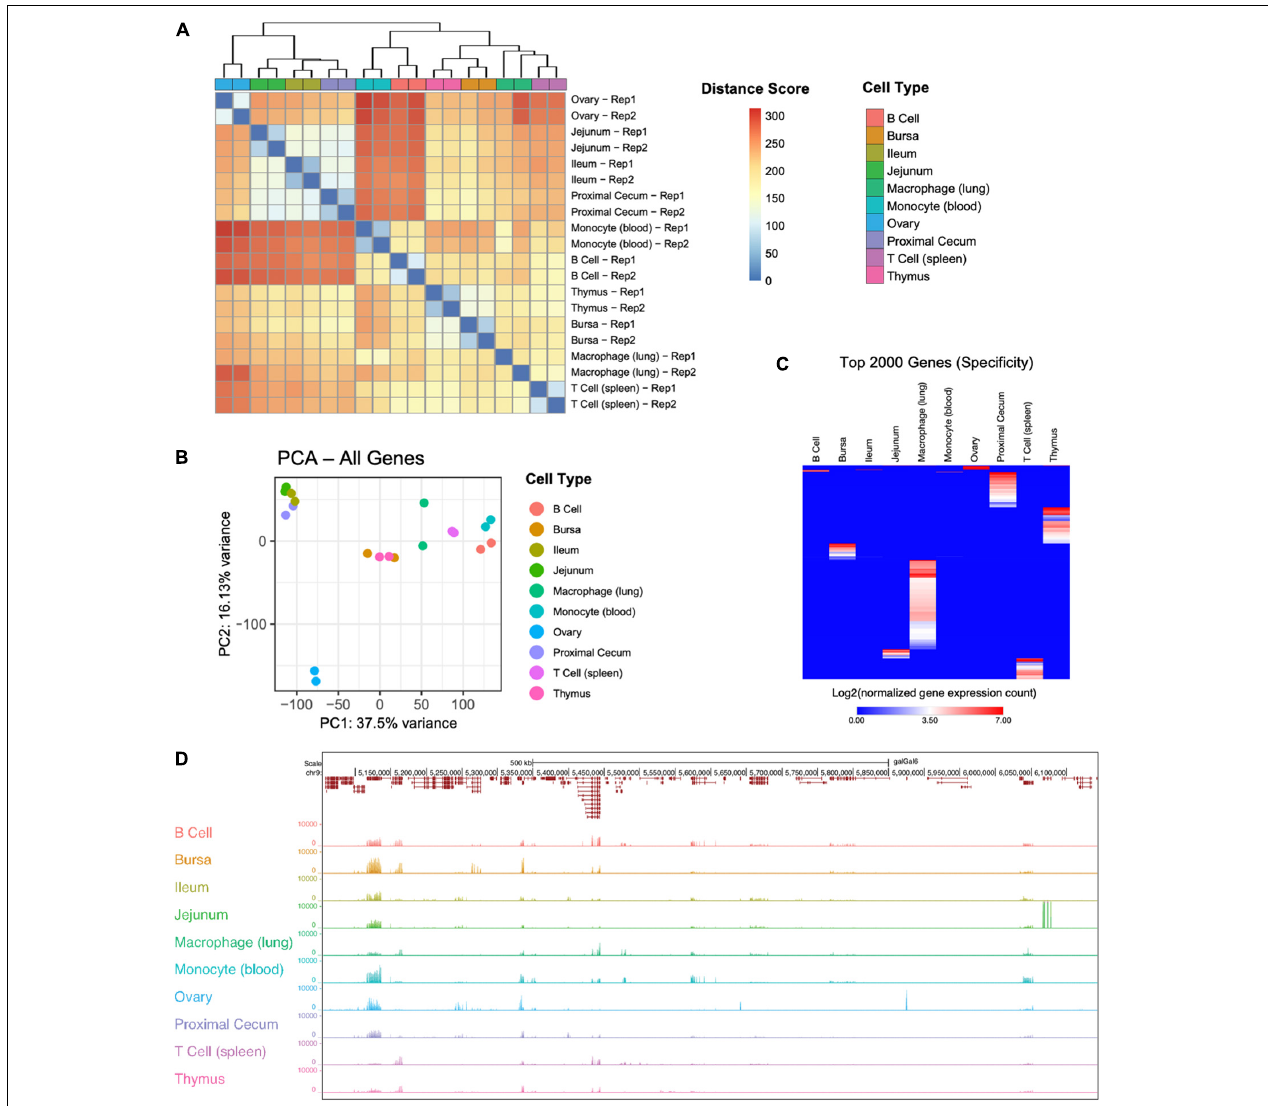
FIGURE 1 | Overview of tissue RNA-sequencing results. (A) Sample to sample distance heatmap quantifying the Euclidean distance between each sample. (B) Principal component analysis using all genes for all samples. (C) Expression of the 2000 genes with the highest Shannon’s entropy values. Rows sorted using Euclidean distance. (D) UCSC browser shot of RNA-seq data showing variable expression among